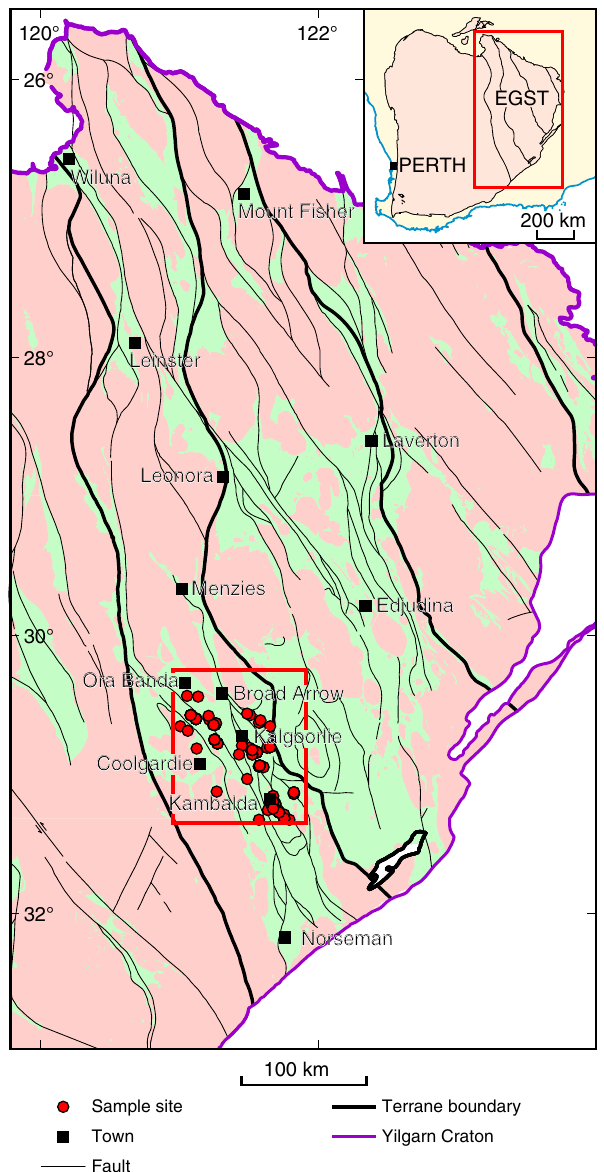
Fig. 2 Location of samples within the Eastern Gold fi elds Superterrane (EGST). Inset outlining the Archean Yilgarn Craton within the southwest of Western Australia. The main map is a simpli fi ed geological map of the EGST showing greenstone belts in green and granitic rocks in pink and the locations of Black Flag Group samples used for this study. Note that many sites represent the location of diamond drill cores from which numerous samples were taken.